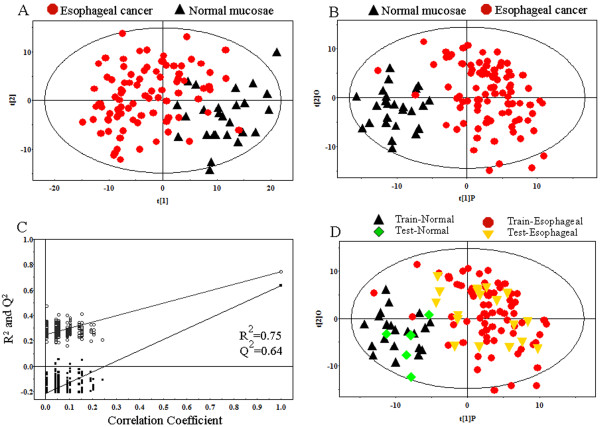
PR of 1H-NMR spectra of tissue specimens. A, scores plot of PCA model based on 26 cases normal mucosae (black triangles) and 89 cases esophageal cancers (red dots). B, scores plot of OPLS-DA model processing based on same samples. C, statistical validation of the corresponding PLS-DA model by permutation analysis (200 times). R2 is the explained variance, and Q2 is the predictive ability of the model. D, scores plot of OPLS-DA prediction model. 80% of samples (training set, normal mucosae =20, esophageal cancer = 71) were applied to construct the model, and then used it to predict the remaining 20% of samples (testing set, normal mucosae =5, esophageal cancer = 18). Green diamonds represent normal mucosae and yellow inverted triangles represent esophageal cancers.